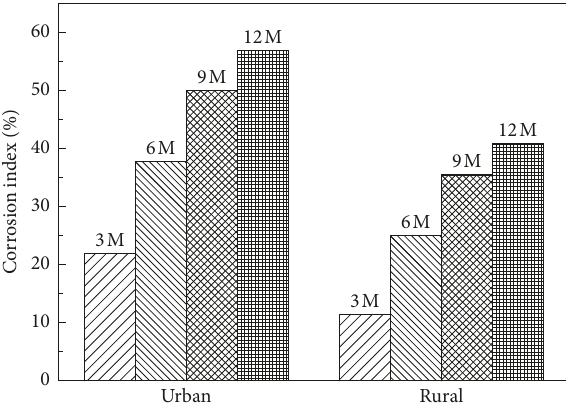
Figure 6: Corrosion index of urban and rural specimens.